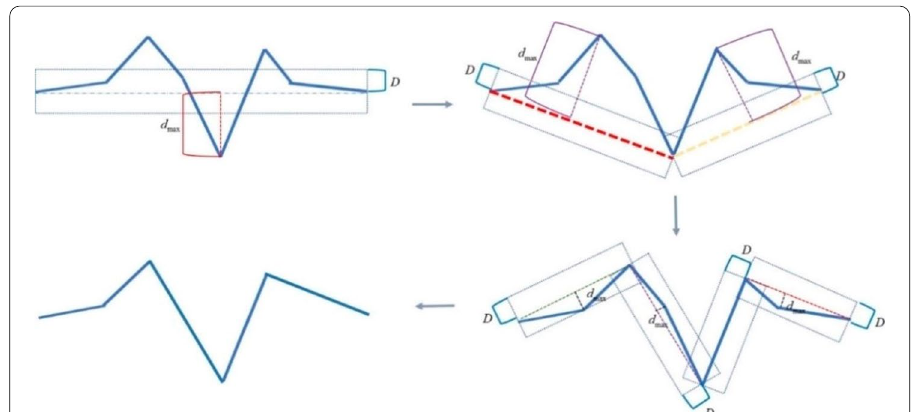
Fig. 2 The process of compression of trajectories by the DP